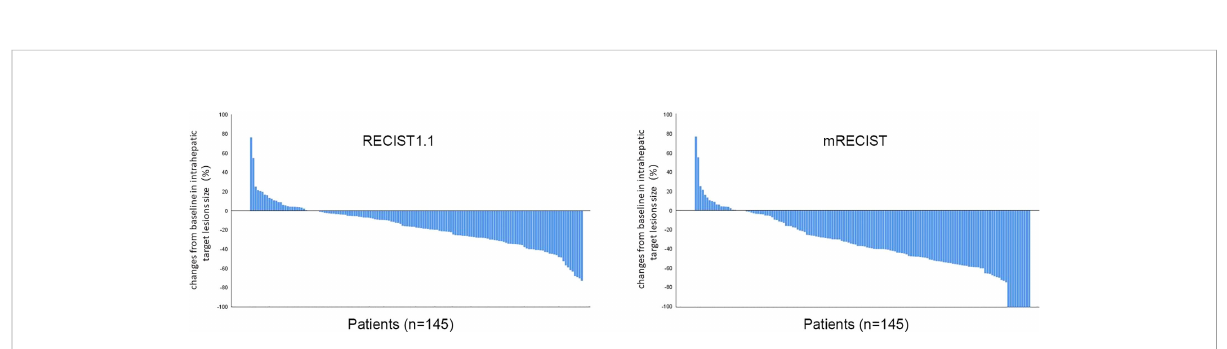
FIGURE 4 Best percentage changes from baseline in size of the intrahepatic target lesions of patients. RECIST1.1, Response Evaluation Criteria in Solid Tumors1.1; mRECIST, modi fi ed Response Evaluation Criteria in Solid Tumors.